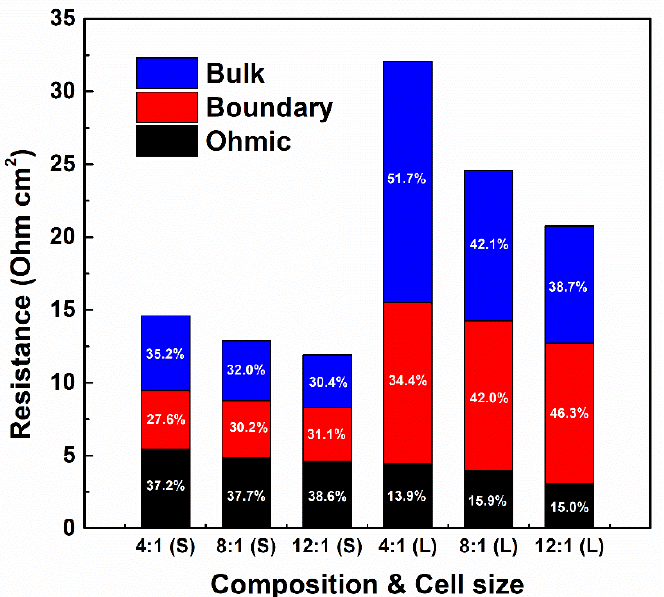
Figure 6. Internal resistance contribution with respect to PIEM composition and RED stack size. The bulk layer resistance is the variation of concentration in the flow channel, which is caused by ion transport from the HC flow channel to the LC flow channel through the active surface of the IEMs. As is already known, the LC flow channel has the highest electrical resistance in the RED stack [13,34,44]. The intensity of the bulk layer resistance is determined by the ion transport rate and retention time of the feed solutions. During RED stack operation, the ion transport rate could be estimated based on the electrical current by assuming that electro-neutrality and charge neutrality were satisfied across the PIEMs and electrodes. In addition, the ion transport rate and retention time are significantly related to the compositions and active areas of the IEMs, respectively. In this study, the bulk layer resistances were sensitive to changes in the stack size and PIEM compositions; these results were noticeable in large RED stacks. In particular, the contribution of the bulk layer resistance to the internal resistance of the RED stack was 51.7% in the large RED stack with a 4:1 PIEM composition. The entirety of the bulk layer resistance increment in the large RED stack was attributed to slow ion transport from the HC to LC feed solutions through the PIEMs, which is attributed to reductions in the salinity gradients between feed solutions by enlarging the stack size. However, the bulk layer resistance in the large RED stack was dramatically reduced with a decrease in the electrical resistance of the PIEMs. This phenomenon indicates that, even with decreasing salinity gradient between the feed solutions in the large RED stack, the low electrical resistance of the PIEMs could still have a significant effect on the rapid transport of ions through the PIEMs in the large RED stack, as compared with the small